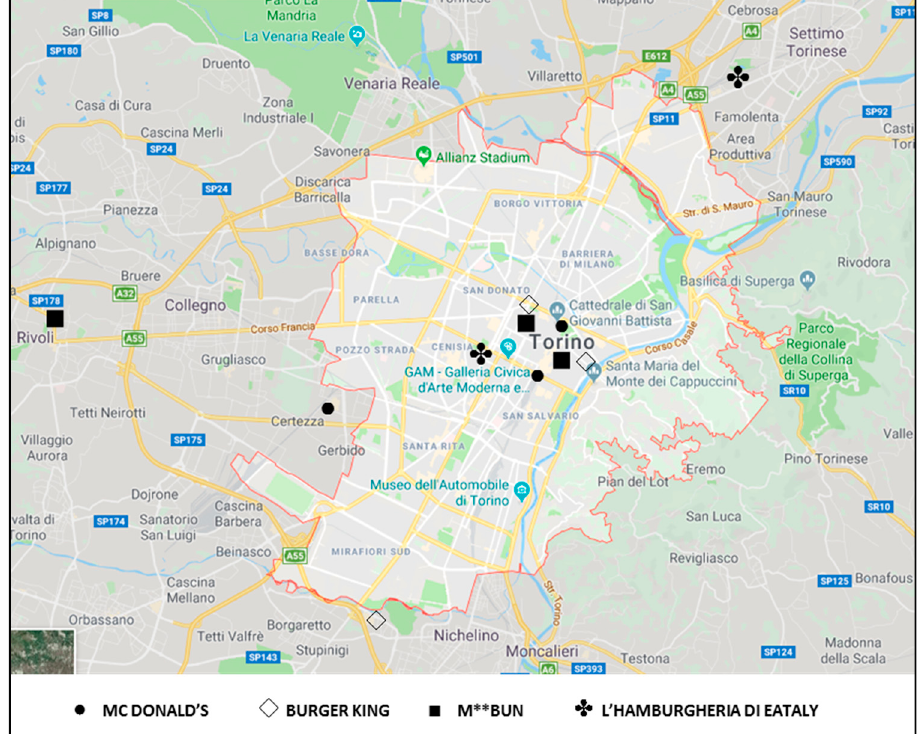
Figure 1. The selected restaurants in the Greater Torino area. Source: Authors’ elaboration.